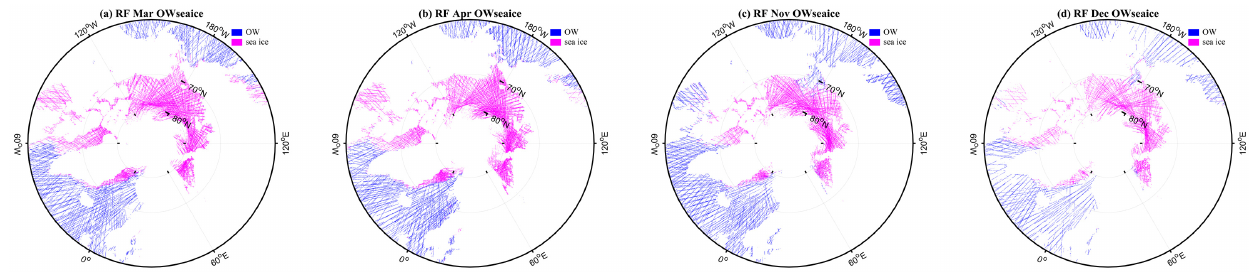
Figure A1. RF for OW-sea ice classification using the data in February as the training set. The data in ( a ) March, ( b ) April, ( c ) November, and ( d ) December are used as the test set in turn.